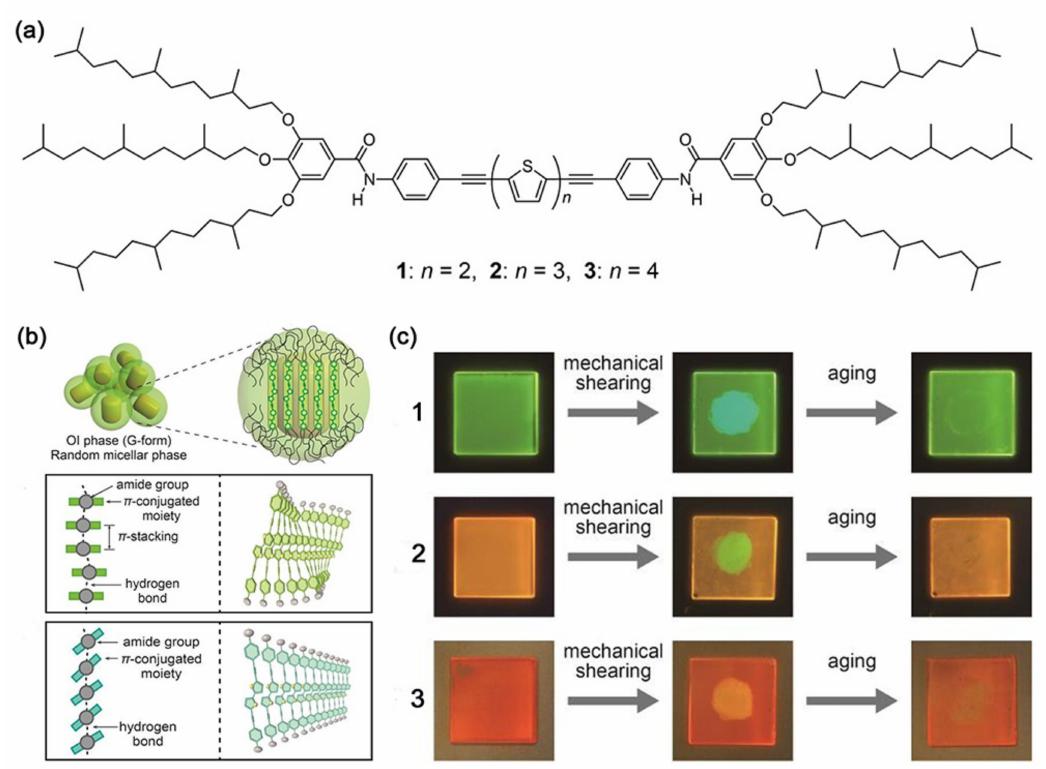
Figure 9. ( a ) Chemical structures of LC compounds 1–3. ( b ) Schematic illustrations of compound 1 assembly, the optically isotropic (OI) phase (G form) and the unidentified mesophase (M) phase (BG form). ( c ) Luminescence images of compounds 1–3 under UV irradiation (365 nm) before (left) and after shearing (center), and after aging at ambient temperature (right). Reprinted with permission from reference [135]. Copyright (2016) Royal Society of